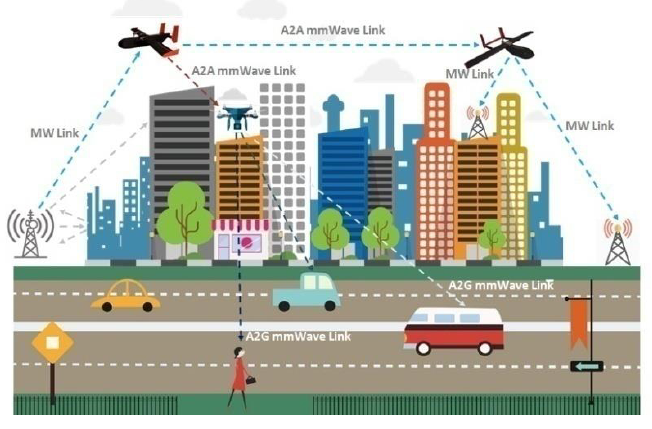
Fig 7. UAVs to assist the network in a dense city UAV Assisted Macro to Small Cell Primary